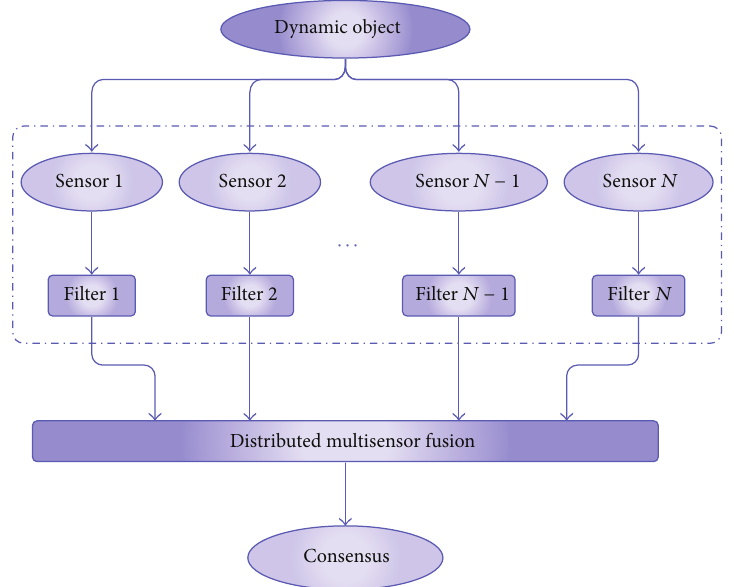
Figure 1: The architecture of the consensus filtering